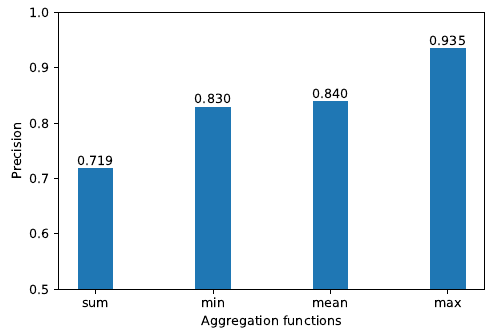
Figure 8. Impact of different aggregation